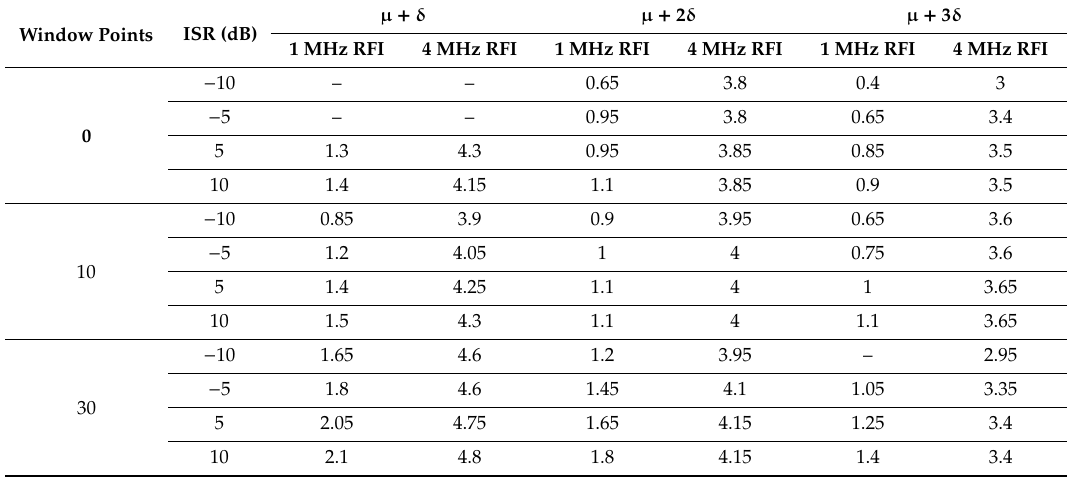
( g ) ( h ) ( i ) Figure 3. Comparisons of the range spectrum smoothing results using different smoothing window Figure 3. Comparisons of the range spectrum smoothing results using di ff erent smoothing window sizes under different ISRs. ( a ) The original spectrum, ISR = – 10dB; ( b ) after 10 points smoothing, ISR sizes under di ff erent ISRs. ( a ) The original spectrum, ISR = − 10 dB; ( b ) after 10 points smoothing, = – 10dB; ( c ) after 30 points smoothing, ISR = – 10dB; ( d ) the original spectrum, ISR = – 5dB; ( e ) after 10 ISR = − 10 dB; ( c ) after 30 points smoothing, ISR = − 10 dB; ( d ) the original spectrum, ISR = − 5 dB; points smoothing, ISR = – 5dB; ( f ) after 30 points smoothing, ISR = – 5dB; ( g ) the original spectrum, ISR ( e ) after 10 points smoothing, ISR = − 5 dB; ( f ) after 30 points smoothing, ISR = − 5 dB; ( g ) the original = 5dB; ( h ) after 10 points smoothing, ISR = 5dB; ( i ) after 30 points smoothing, ISR = 5dB. spectrum, ISR = 5 dB; ( h ) after 10 points smoothing, ISR = 5 dB; ( i ) after 30 points smoothing, ISR = 5 dB. Table 3. RFI bandwidth identification using di ff erent window sizes under di ff erent Table 3. RFI bandwidth identification using different window sizes under different ISRs.